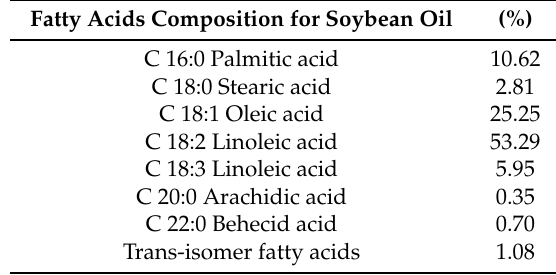
Table 1. Composition of the soybean oil we used in our study. Fatty Acids Composition for Soybean Oil